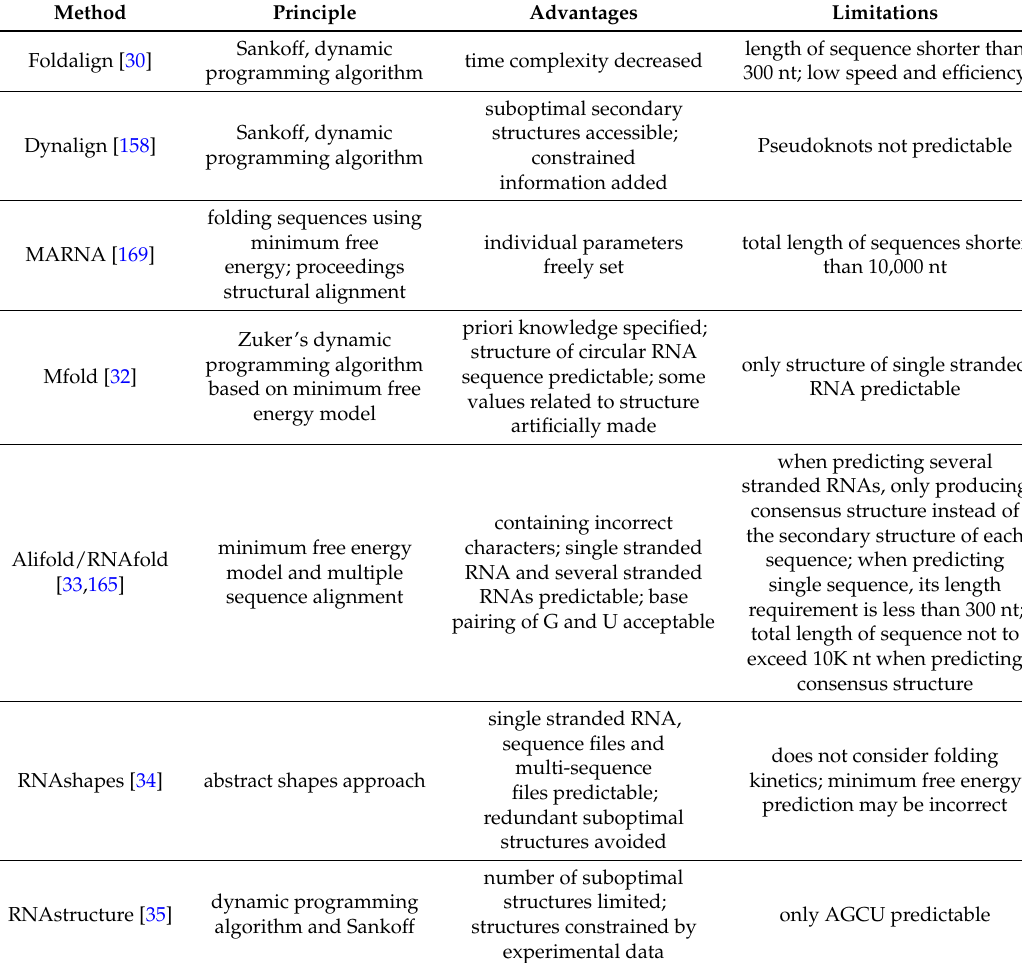
Table 1. Comparison of the various major methods to predict RNA secondary